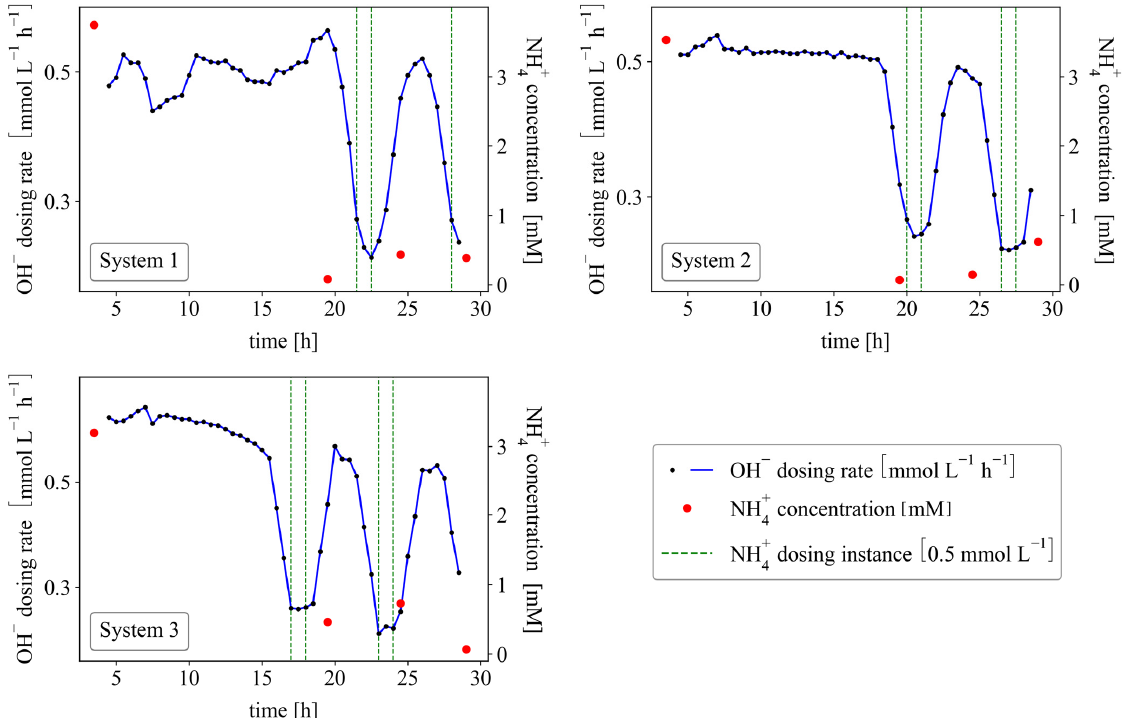
Figure 3. Results from run 3 in a batch setup. Ammonium extinction was inferred from a 50% reduction in the hydroxide dosing rates (6 point running average). This was accomplished with the control algorithm presented in Figure 2. The hydroxide dosing rates are shown as blue lines for each of the 3 systems. Ammonium dosing instances are shown as vertical green dashed-lines (which occurred upon a 50% reduction in the hydroxide dosing rate). Ammonium extinction was confirmed by measurement of the ammonium concentrations in solution (red dots). “Spot checks” were done for nitrite, of which none was measured (<0.001 mM).